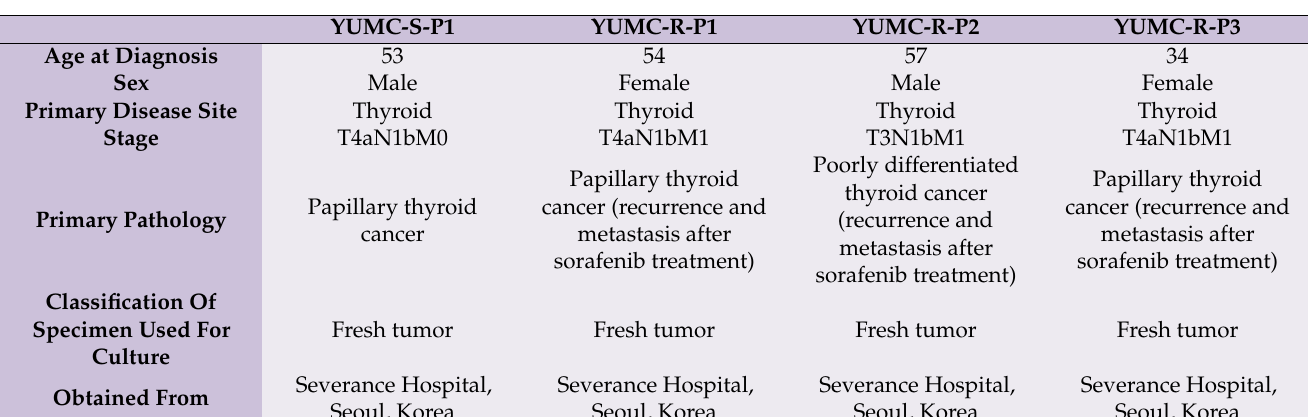
Table 1. Patient characteristics, clinical features, and information on human sorafenib-sensitive